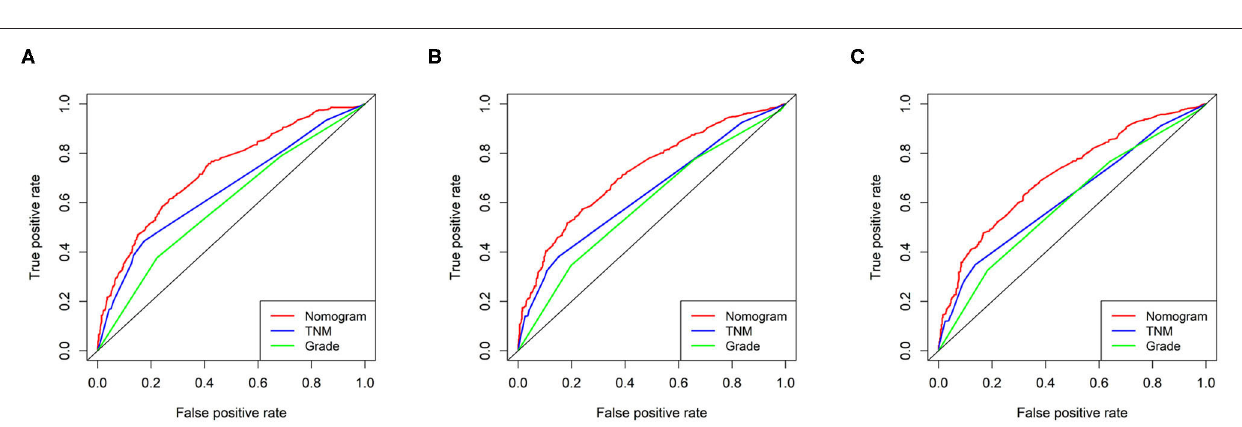
FIGURE 1 | Nomogram for the prediction of 1-, 2- and 3-year overall survival in ccRCC patients with distant metastasis.